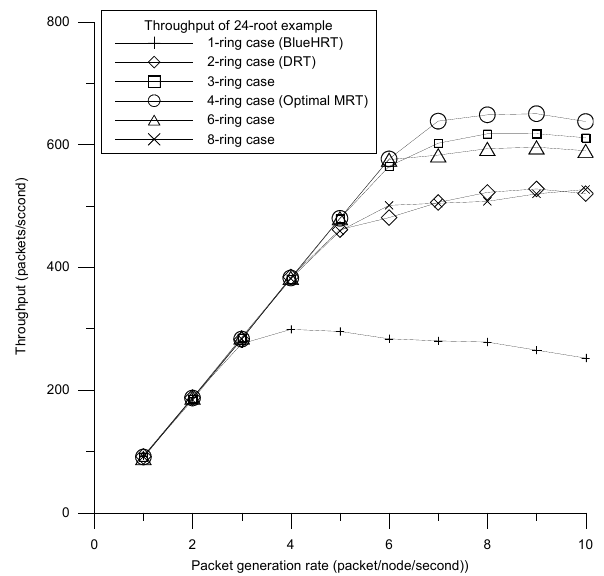
Figure 10. Throughput performance of the Optimal MRT, DRT, and BlueHRT.